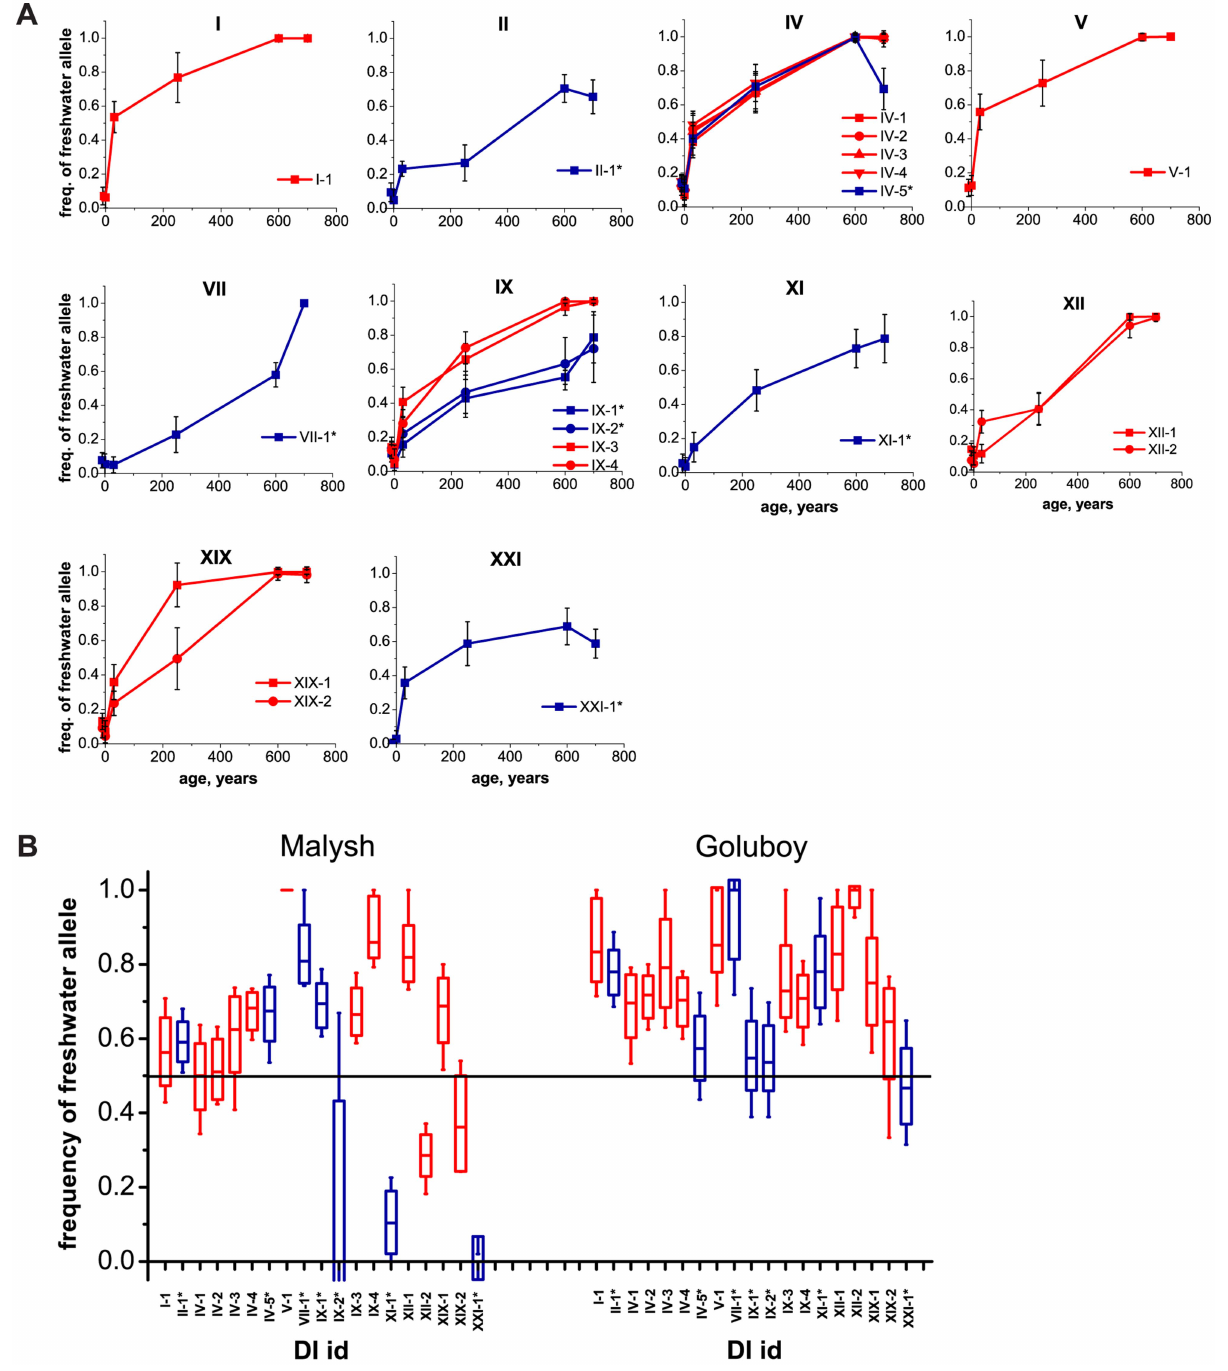
Figure 3. Mean frequencies of freshwater alleles at marker SNPs within identified DIs, at freshwater populations of different ages. ( A ) Natural populations. The horizontal axis shows the approximate ages of populations, ranging (left to right) from two marine populations ( , 0 years) to recent ( , 34 and , 250 years) and older lake populations ( , 600 and , 700 years). Whiskers, standard deviation. ( B ) Experimental populations. For each of the DIs of marker SNPs, the assumed initial 50% frequency of freshwater alleles (black line) and their current frequencies are shown for two experimental populations: quarries Malysh (left) and Goluboy (right), each started in 1978. Dashes, boxes and whiskers correspond to the median, standard deviation, and 5 th and 95 th percentiles, respectively. Red, DIs identified under the strong criterion; blue, DIs identified under the weak criterion.